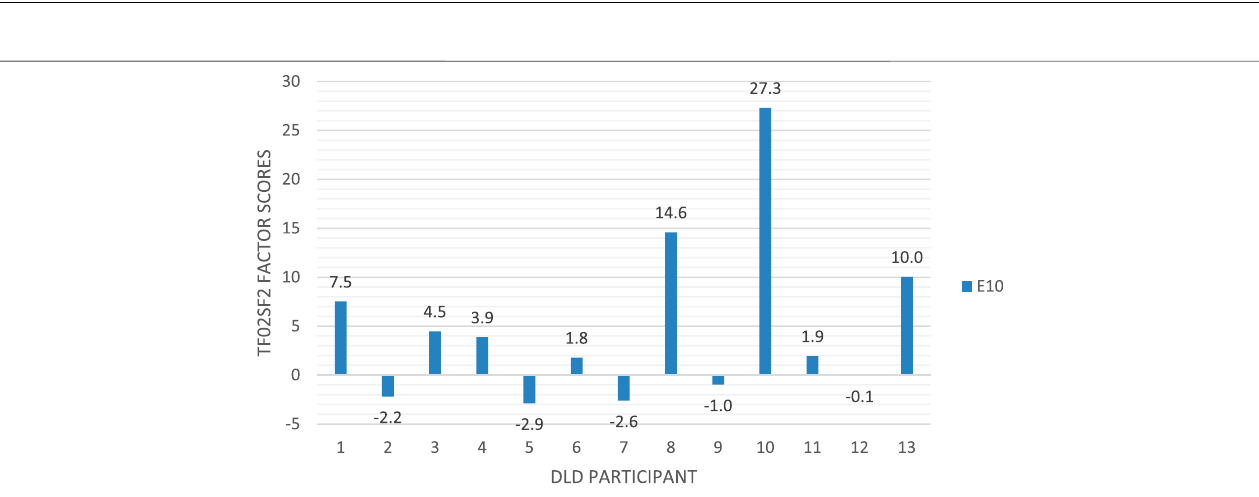
FIGURE 12 | Distribution of individual factor scores (representing the strength to which the individual participant contributed to the late ERP response to the fi lled gap).